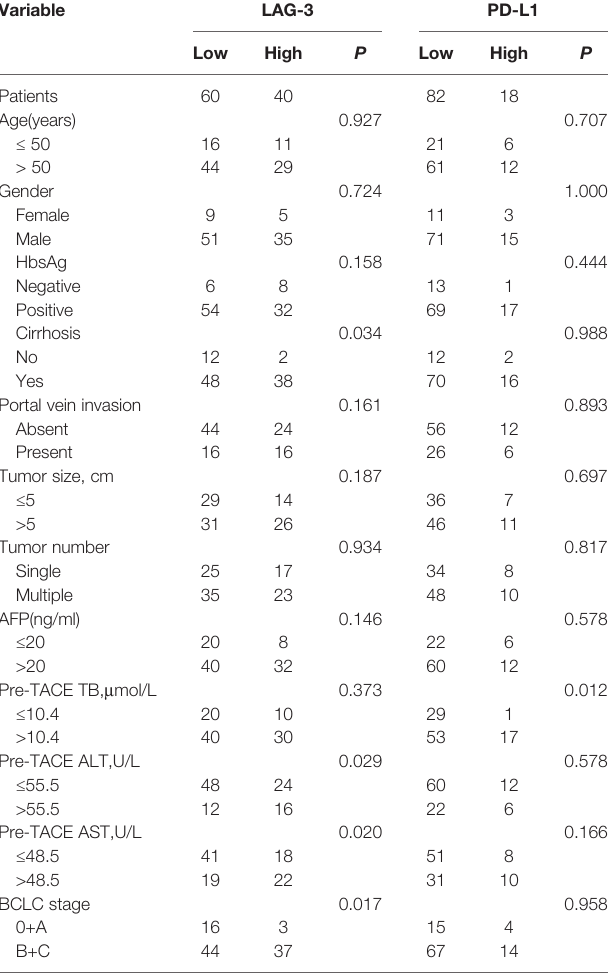
TABLE 3 | The association between the serum LAG-3 and PD-L1 level with clinical characteristics of HCC patients.